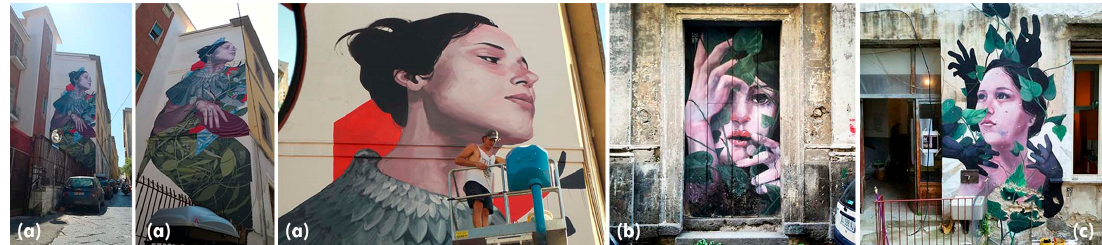
Figure 5. Francisco Bosoletti: ( a ) Parthenope; ( b ) La donna del giardino; ( c ) Le ombre di